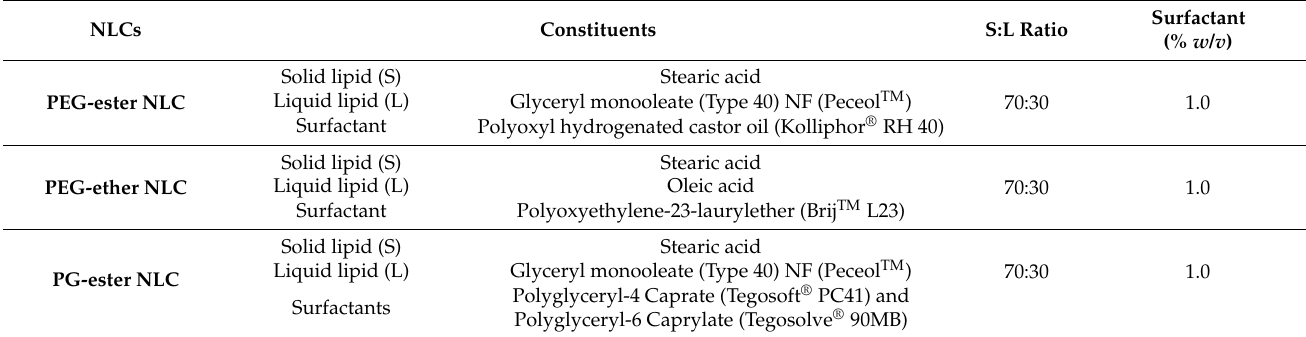
Table 1. Lipid components and surfactants used for NLC